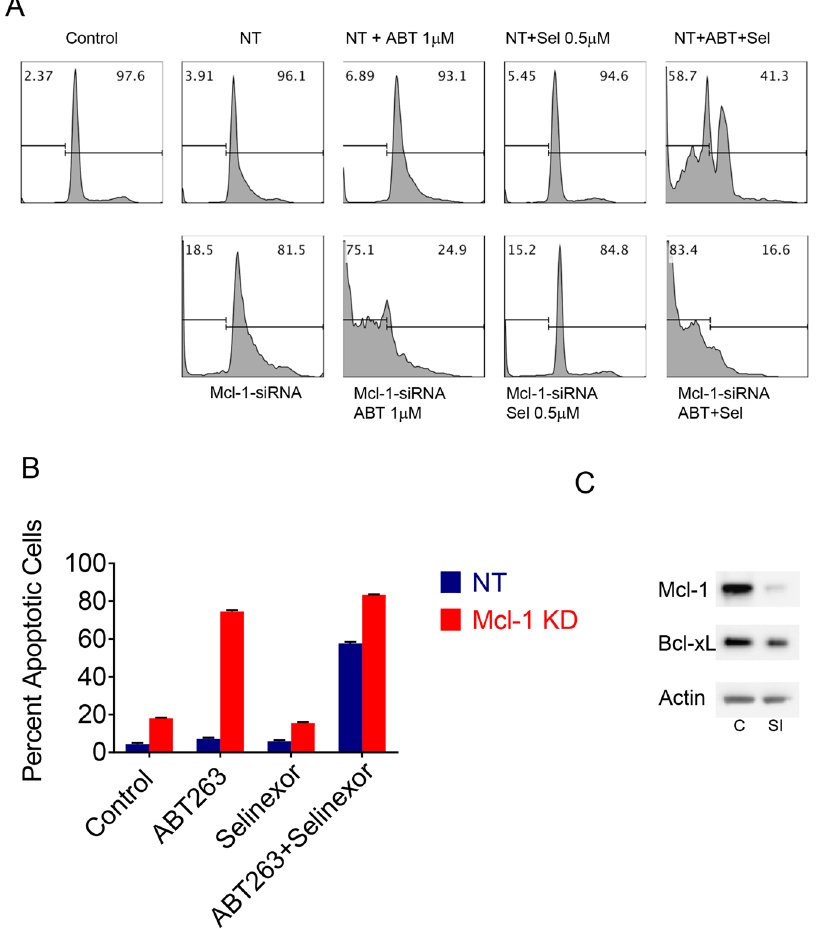
Mcl-1 specific siRNA transfected cells were subsequently exposed to vehicle, ABT263 (ABT), selinexor (Sel) or the combination treatment of ABT263 and selinexor (ABT + Sel). Thereafter, cells were fixed, labeled with propidium iodide and analyzed by flow cytometry. Shown are representative plots. ( C ) Control; SI: Mcl-1 specific siRNA.; NT: non-targeting siRNA. ( B ) Shown are the quantifications obtained from experiment performed in A. Shown are means and SD. ( C ) LN229 GBM cells were transfected as in A. Whole cell protein lysates were collected and analyzed for the expression of Mcl-1 and Bcl-xL by standard western blotting (C: Control, non-targeting siRNA; SI: siRNA